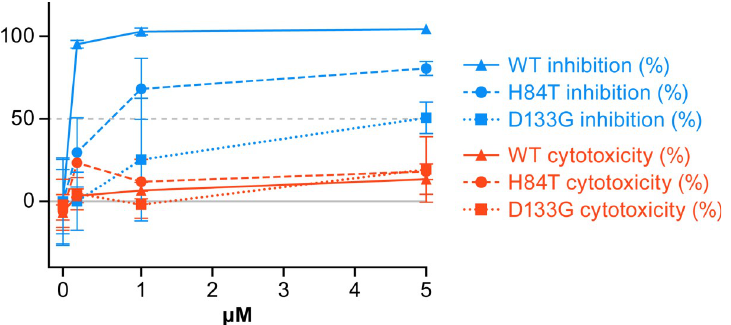
Fig 7. Comparative effects of WT, H84T and glycan binding-deficient D133G BanLec on EBOV trVLP infection and cytotoxicity. 293T/17 cells were pretreated with the indicated concentrations of WT (triangles; solid lines), H84T (circles; dashed lines), or D133G (squares; dotted lines) BanLec for 1 h and then processed for trVLP infection (blue) as in the legend to Fig 4 and for cytotoxicity (red) as described in the Methods section. Data (y-axis) are the averages of triplicate samples ± SD: % cytotoxicity (red), % inhibition of infection (blue).